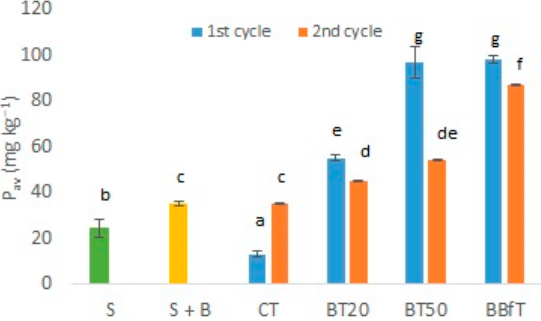
Figure 4. Available phosphorus (P av ) in studied soil (S), with biochar (S + B), and with different